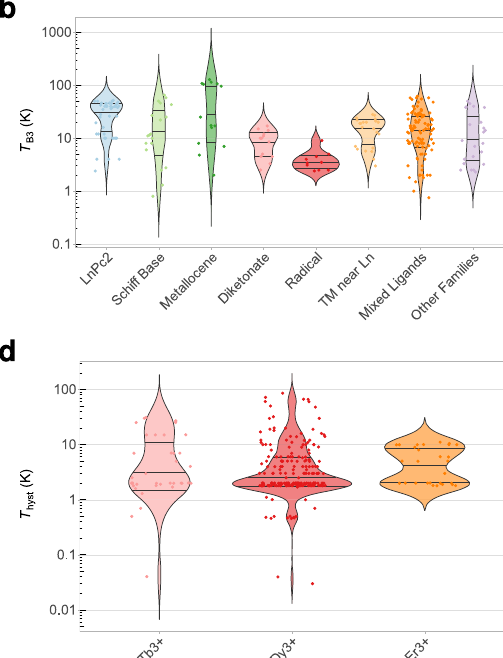
Fig.3|Violinplotsandbarchartsrelatingmagneticrelaxationbehaviourwith the main chemical parameters. The width of each violin plot is proportional to the density of data points for this range of values, and the horizontal stripes mark